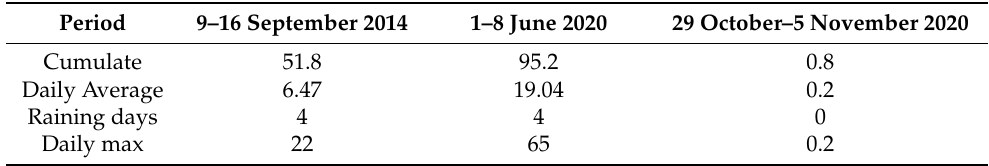
Table 2. Precipitation (mm day − 1 ) at the Piancastagnaio weather station in the eight days before samplings. Data obtained from Ref.